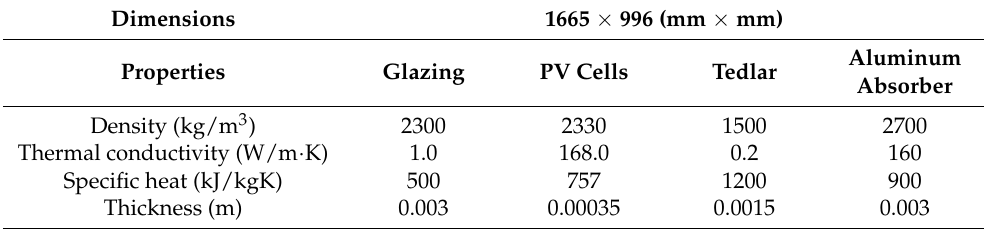
Table 2. PV/T investigated